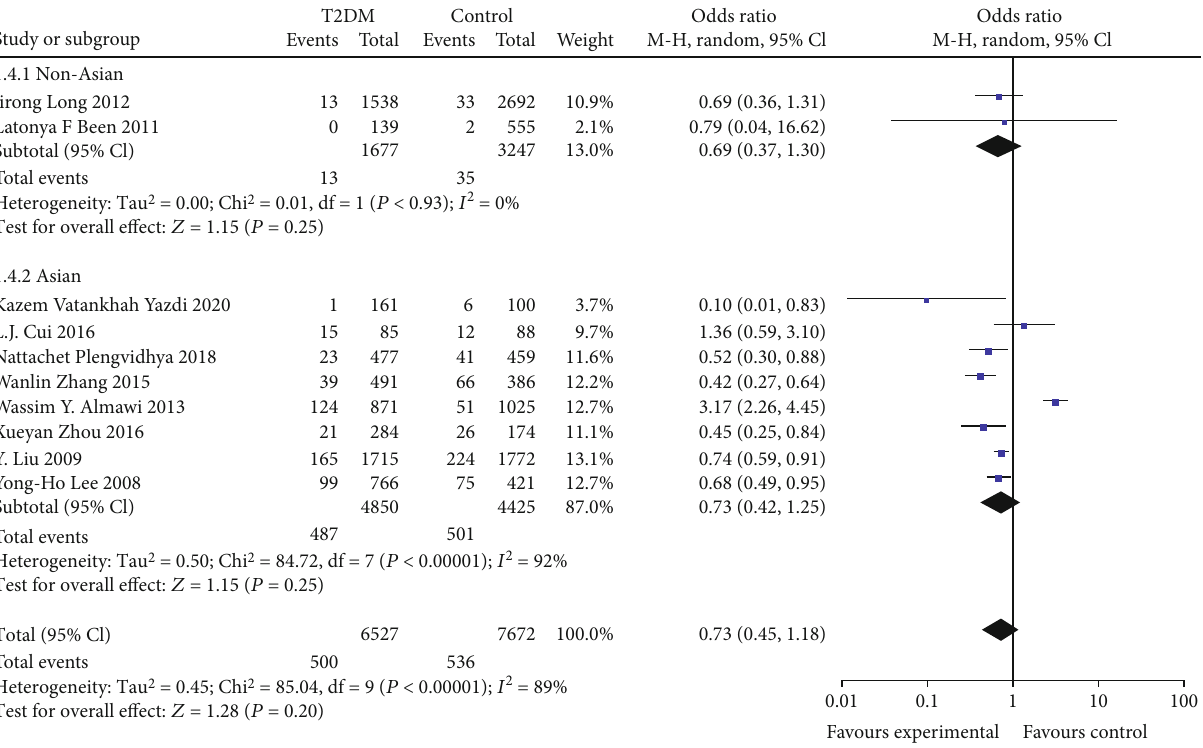
Figure 5: Forest plot of meta-analysis of the association between KCNQ12237892 locus and T2DM under the recessive model (strati fi ed